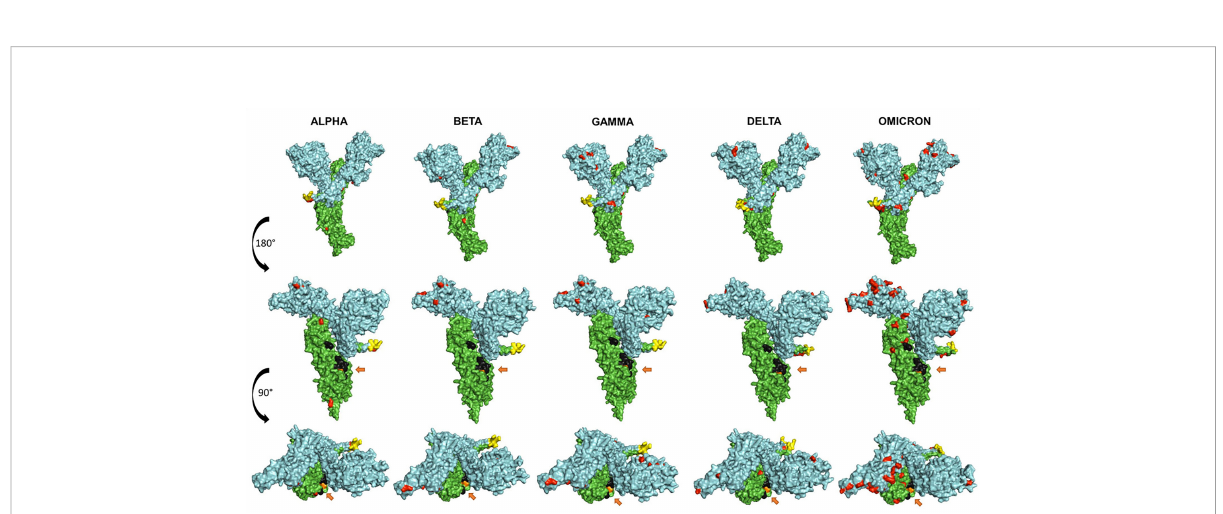
FIGURE 5 Representation of the surface models of SARS CoV-2 variant S spike protein (monomer). Side views (upper and middle rows) and top view (third row). Color coding is as follows: mutations (red), S1 subunit (cyan), S2 subunit (green), furin cleavage site (yellow), fusion peptides FP1 and FP2 (black), and the arrows show the TMPRSS2 cleavage site (orange).